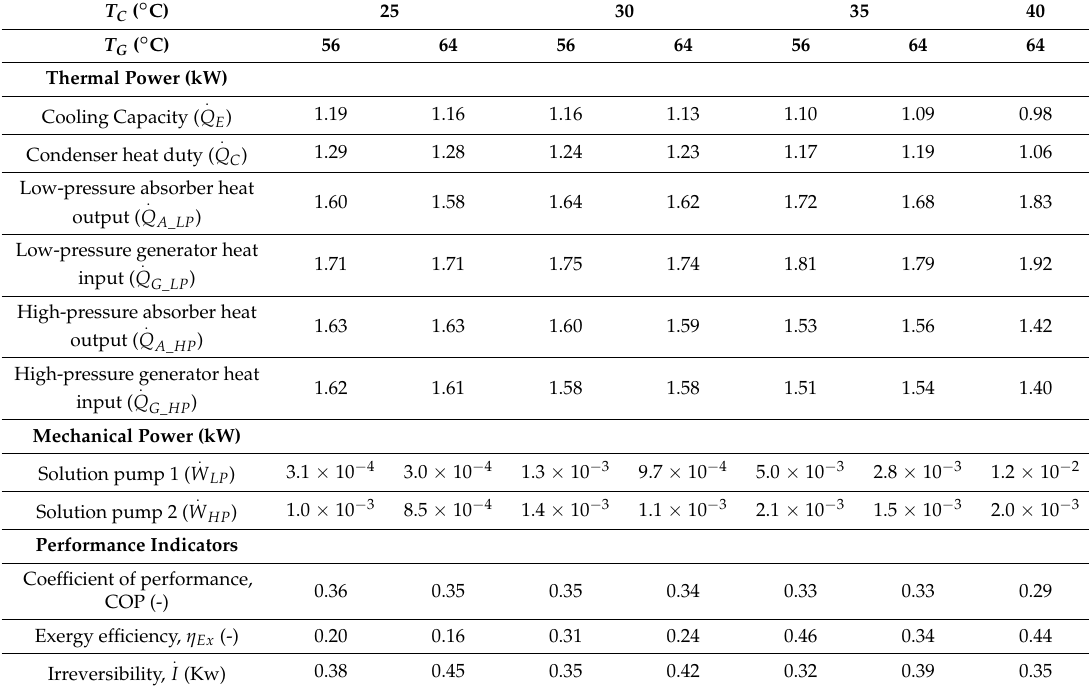
Table 4. Performance summary of the modeling of well W1 coupled to a half-effect cooling system. Case study: Air conditioning ( T E = 10, PF =